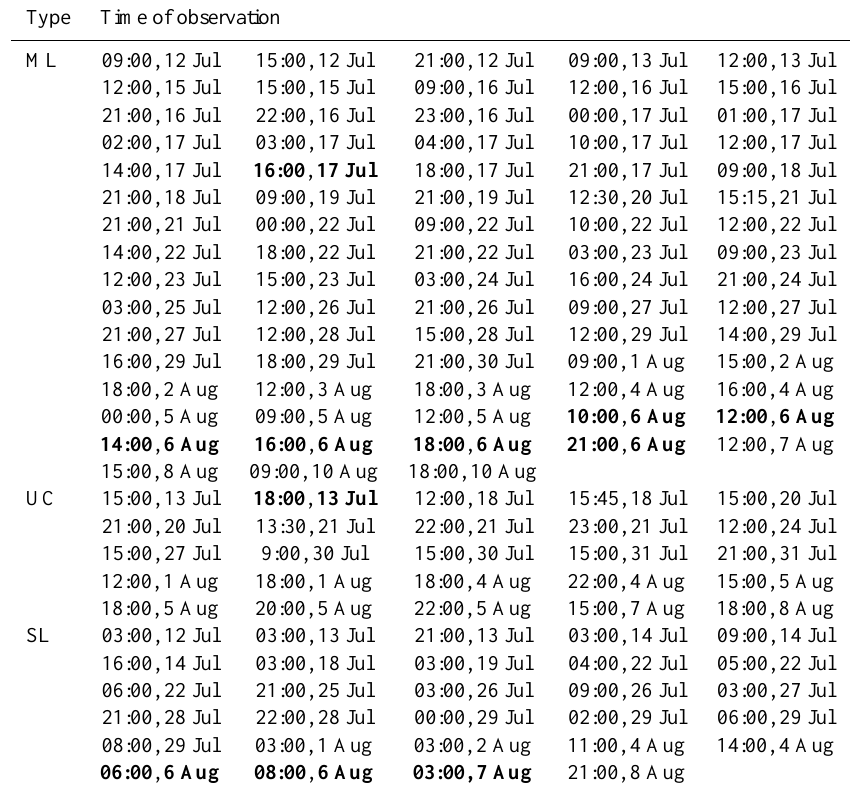
Table 2. Occurrence of atmospheric boundary layer prototypes during HUMPPA-COPEC-2010 according to the radiosonde observations. Listed are the local daylight saving times (UTC+3). Times printed in bold correspond to radiosonde profiles used in this study. The three distinguished prototypes are the mixed layer, ML, the mixed layer topped with a conditionally unstable layer, UC, and a stable boundary layer,